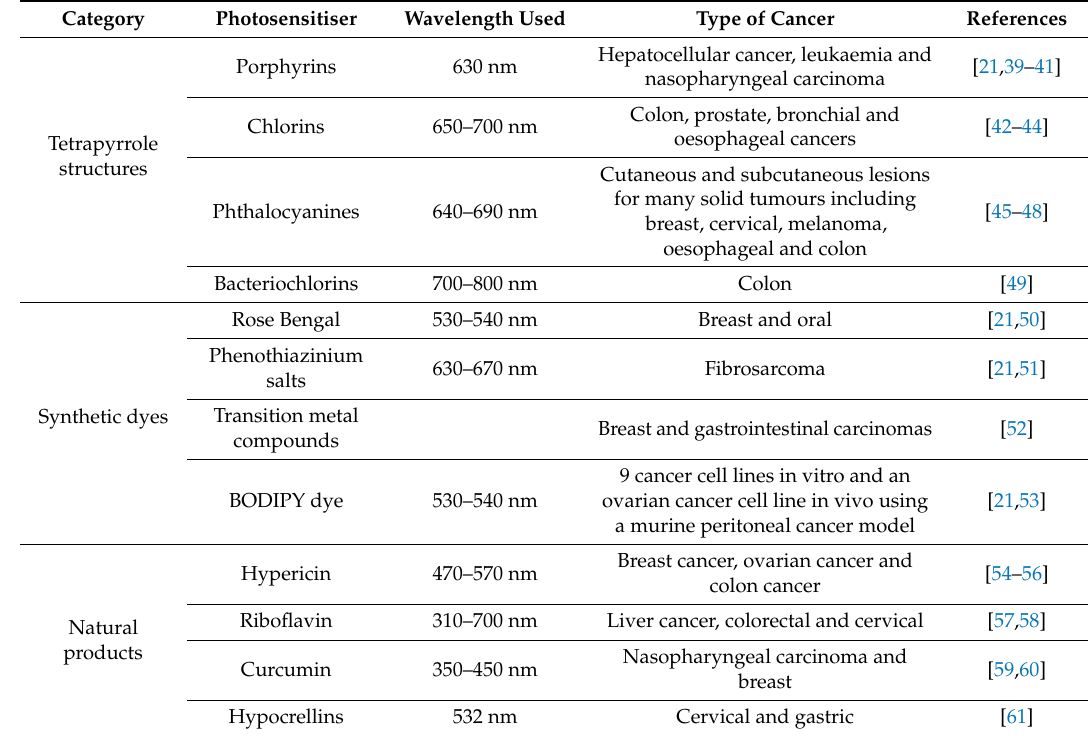
Table 2. Di ff erent types of photosensitisers and their application in di ff erent